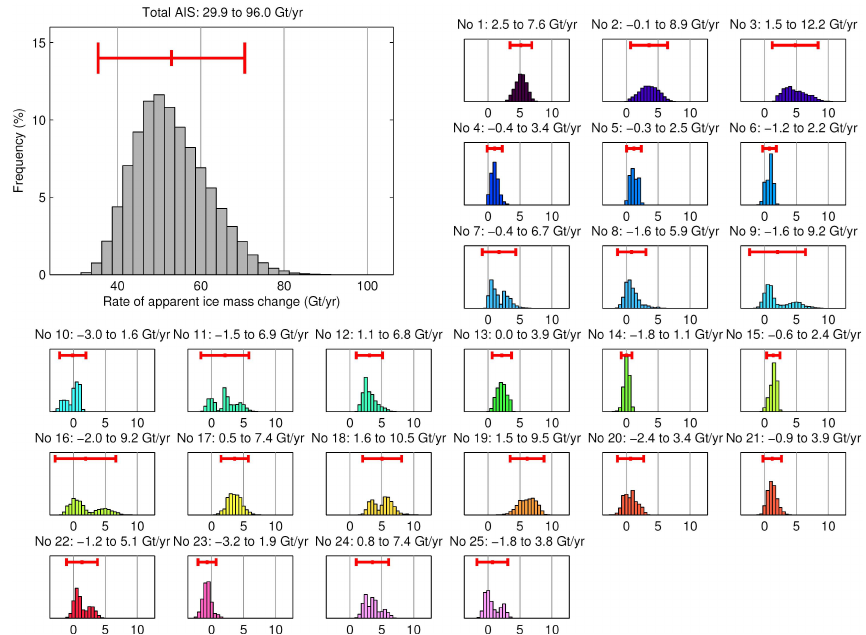
Fig. 5. Distribution of the rate of apparent ice-mass change (Gtyr − 1 ) induced by the GIA for the total AIS and the 25 basins, obtained by constraining the ensemble of per-sector combinations (995328 samples) with GPS and GRACE (GRACE and GPS comb.). The apparent ice-mass change is calculated by applying the gravimetric inversion method for the present-day ice-mass changes to each estimate of the GIA-induced gravity